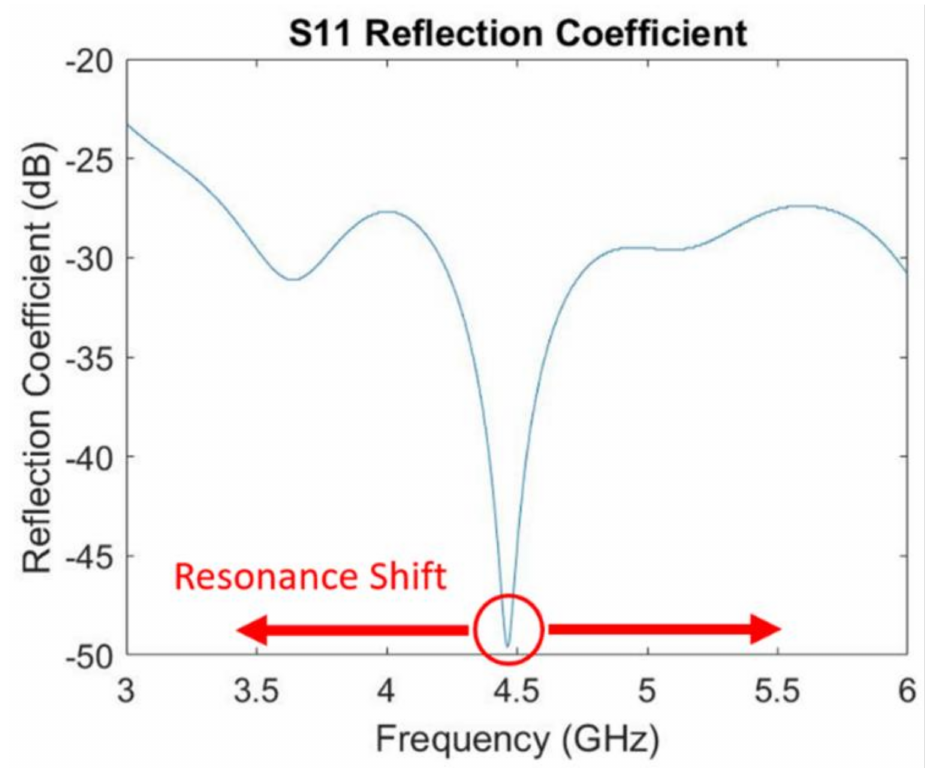
Figure 15. Resonant frequency at the minimum of the reflection coefficient (S11)